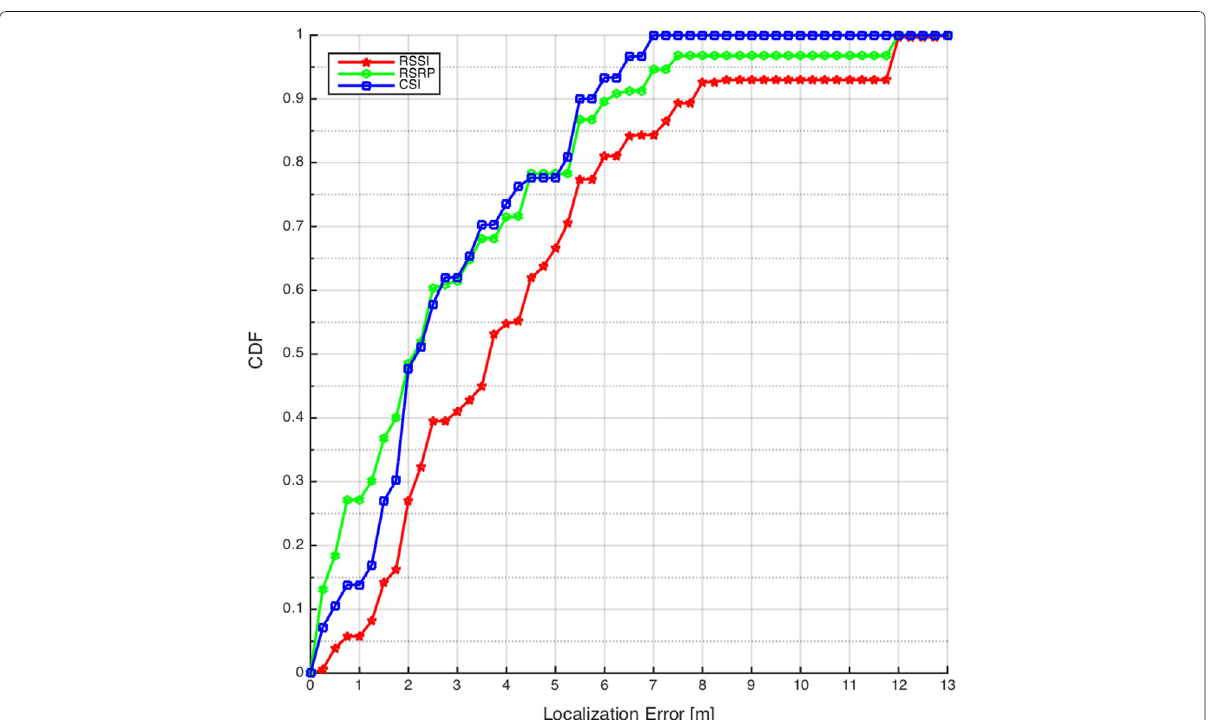
Fig. 8 CDF of the localization error in a narrowband scenario. Comparison of cumulative distribution functions of the localization error for signal fingerprinting approaches based on RSSI, RSRP, and